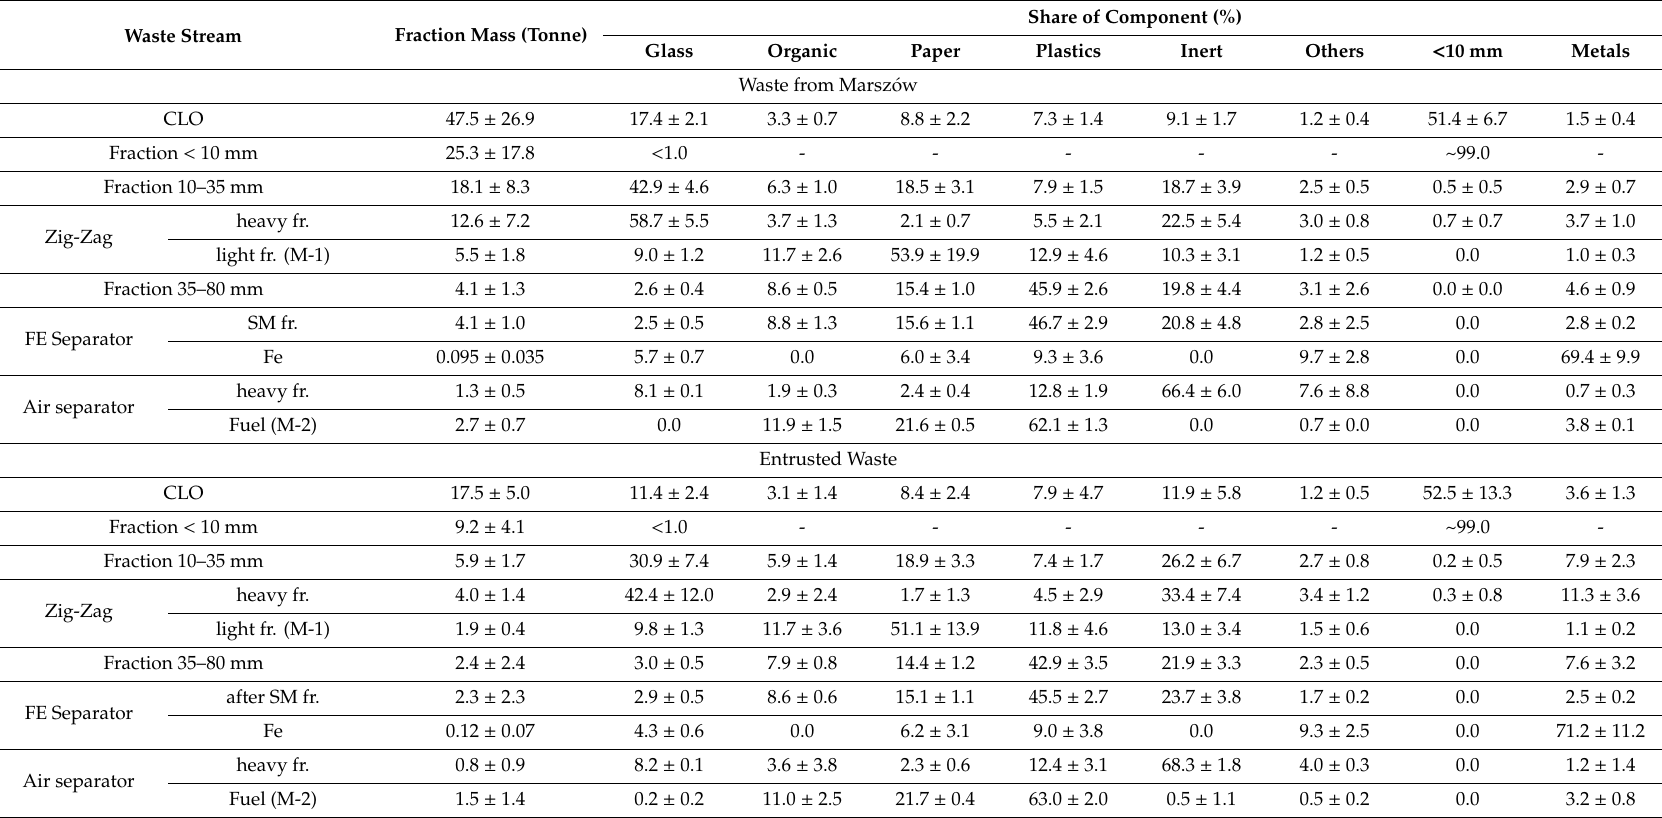
Table 3. Characteristics mass and material composition of intermediate products obtained in subsequent stages of the processing of CLO from Marsz ó w and material entrusted from other mechanical-biological waste treatment (MBT)